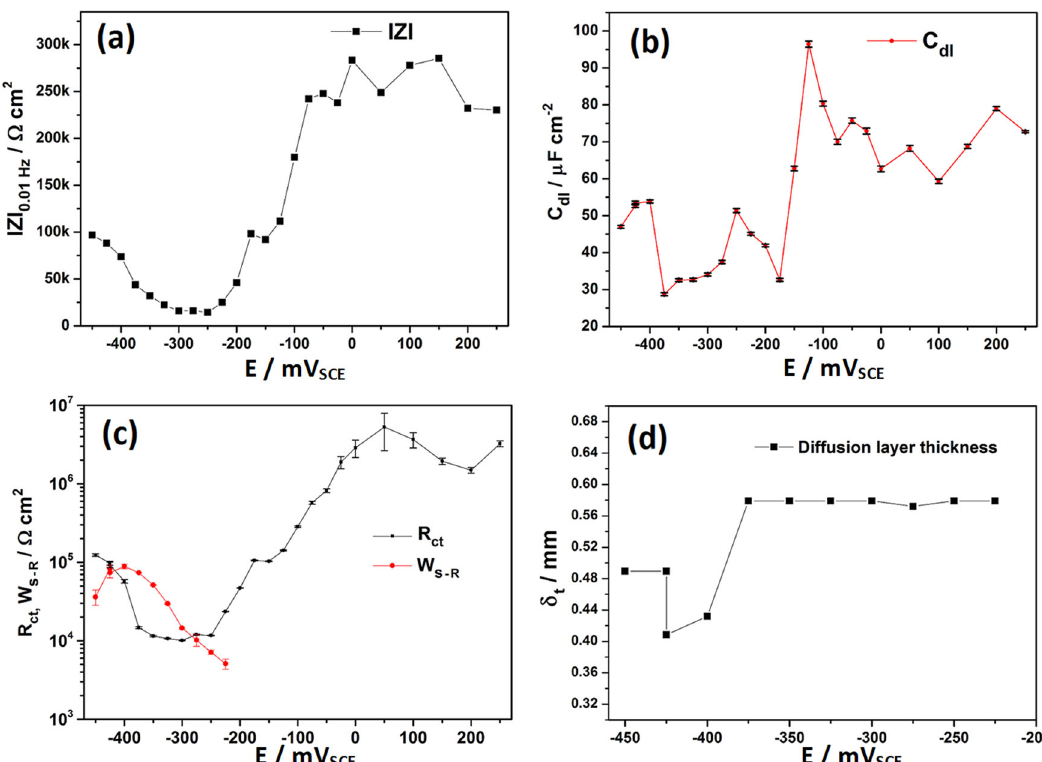
Fig. 10 Parameters for CFRP extracted from EIS at various polarizations. Parameters extracted from the EIS spectra as a function of potential around the diffusion-limited potential ranges for CFRP in 50 mM NaCl, a low-frequency impedance at 10 – 2 Hz, b calculated double-layer capacitances, c evolution of polarization or charge transfer resistance (R ct ), and the resistive component of Warburg impedance (W S-R ), and d the diffusion layer thickness estimated from EIS data (Error bars denote fi tting errors from the model equivalent circuit used to fi t data/ extract parameter).